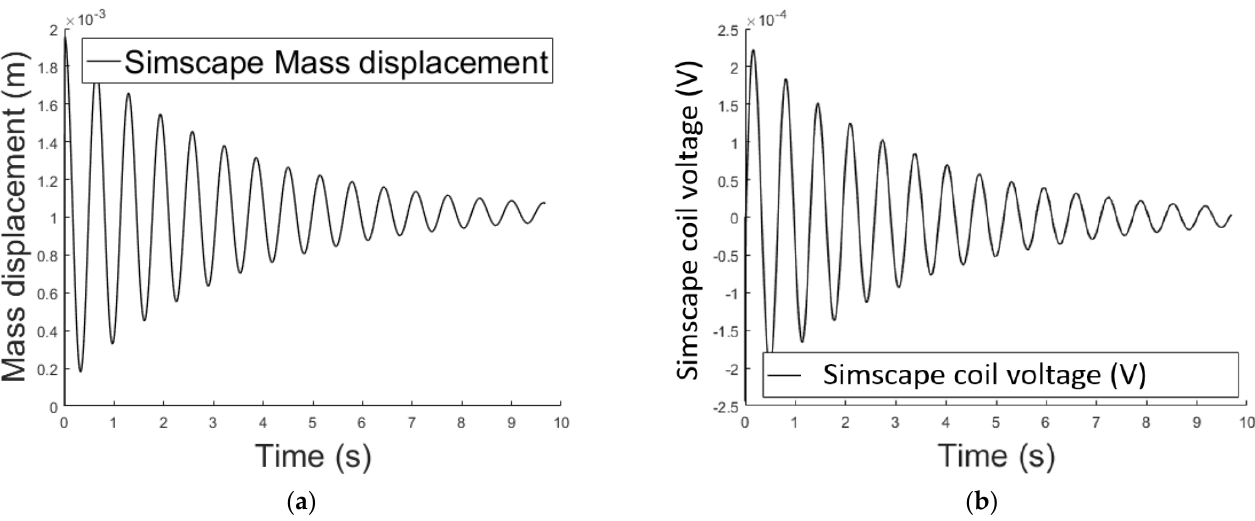
Figure 4. ( a ) Air gap length variation over time using the Simscape implementation; ( b ) variable voltage across the electromagnet’s coil over time using the Simscape implementation.